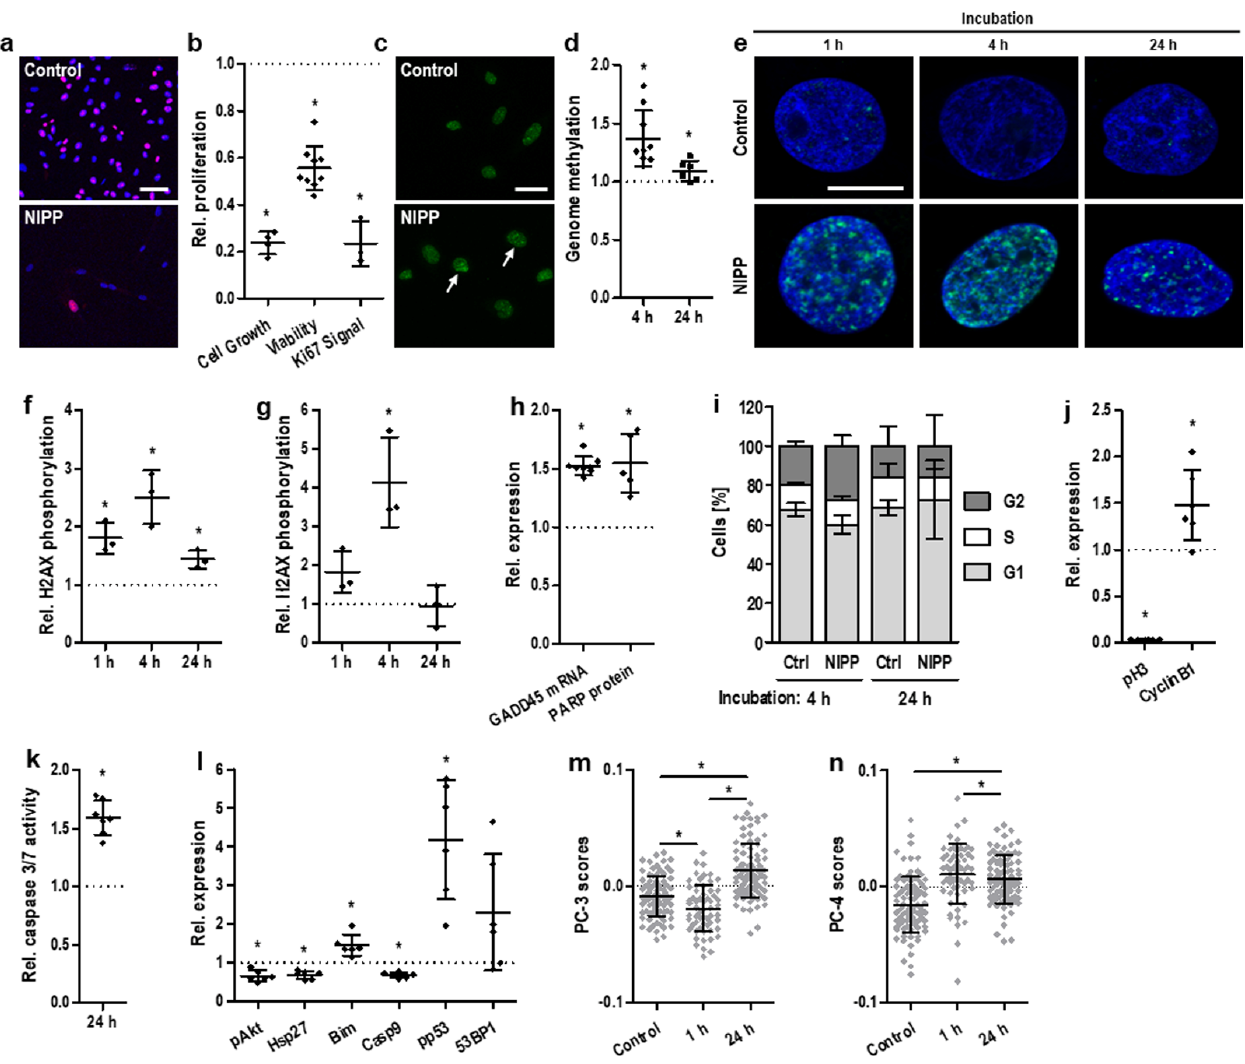
Figure 1. In vitro NIPP treatment induces antiproliferative cell effects at different molecular interfaces. ( a ) Representative IF staining of Ki67 72 h after 30 s of NIPP treatment and ( b ) relative antiproliferative efficacy 72 h after 30 s of NIPP treatment), shown as relative decreases in cell number, cell viability, and Ki67 expression; the scale bar equals 40 µ m. ( c ) Representative IF staining of 5mC 4 h after 30 s of NIPP treatment and ( d ) relative genomic methylation level per nucleus (number of foci normalized to the control) 4 ( ◆ ) and 24 h ( ■ ) after 30 s of NIPP treatment of cervical cancer cells; the scale bar equals 20 μm. ( e ) Representative IF microscopy of γH2AX and ( f ) relative γH2AX intensity and ( g ) relative γH2AX intensity 1 h, 4 h, and 24 h after 30 s of NIPP treatment of cervical cancer cells, indicating DNA double- strand breaks; the scale bar equals 10 μm. ( h ) Relative induction of growth arrest- and DNA damage-inducible genes GADD45 and PARP 72 h after 30 s of NIPP treatment. ( i ) Relative fractions of cells in 561 cell cycle phases S, G1 and G2 and with reversible phase transition to G2 4 h after 30 s of NIPP treatment. ( j ) Relative expression of the cell cycle factors phospho-histone H3 (Ser10) and CyclinB1 72 h after 30 s of NIPP treatment, indicating G2 arrest. ( k ) Relative caspase-3/7 activity 24 h after 30 s of NIPP treatment. ( l ) Relative expression of the apoptotic factors pAkt, Hsp27, Bim Casp9, pp53, and 53BP1 24 h after 30 s of NIPP treatment. ( m ) PC-3 and ( n ) PC-4 score values for single-cell Raman microspectroscopy of untreated and 30 s NIPP-treated cervical cancer cells after 1 and 24 h, as assessed by PCA; the data for each group originate from 3 independent experiments with 30 cells each. Results are expressed as mean ± SD; ( a – l ): * p < 0.05; paired t test; ( m , n ): one-way ANOVA; * p <